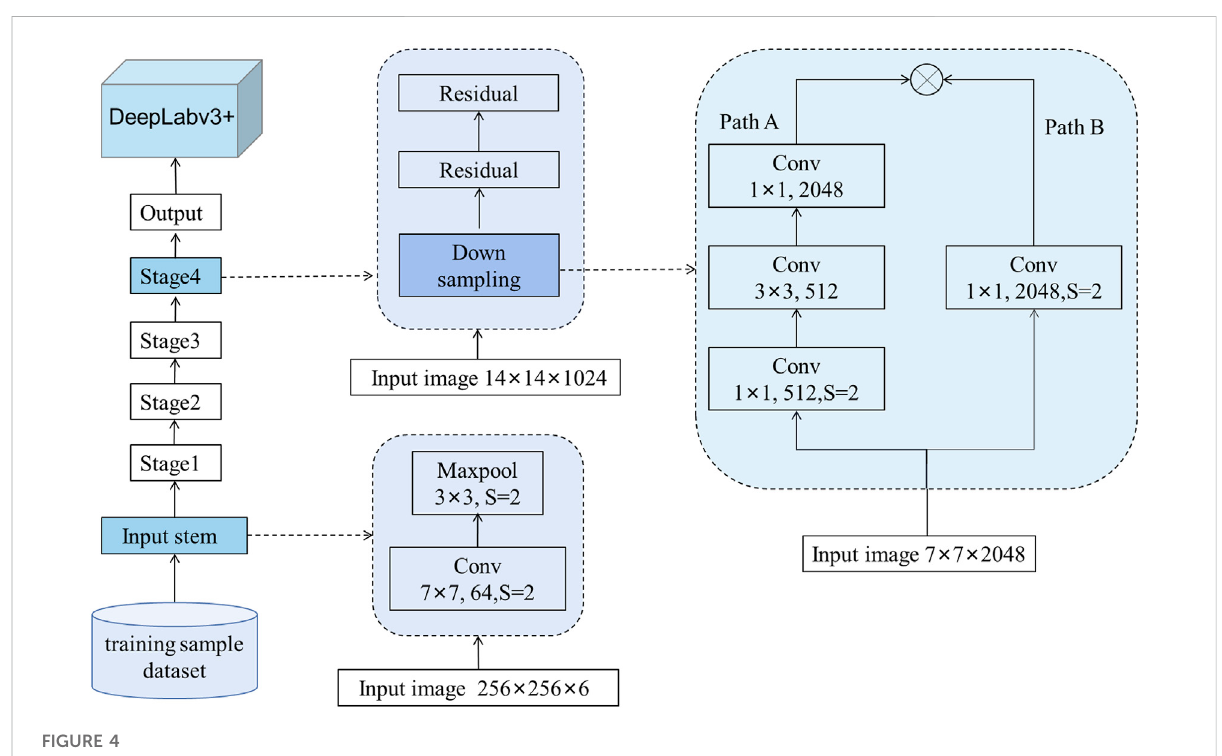
FIGURE 4 Sandstorm detection network